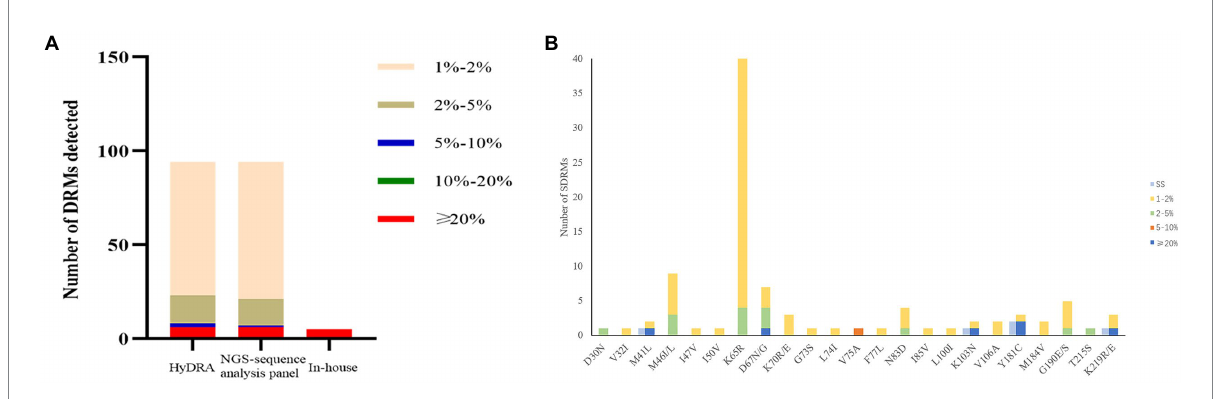
FIGURE 7 (A) The number of DRMs detected by the three detection methods. The range of the interval in the figure was inclusive of the left-side value, and the right-side value was not included. (B) Comparison of HIV-1 SDRMs detected by Sanger sequencing and NGS-sequence analysis panel at different detection